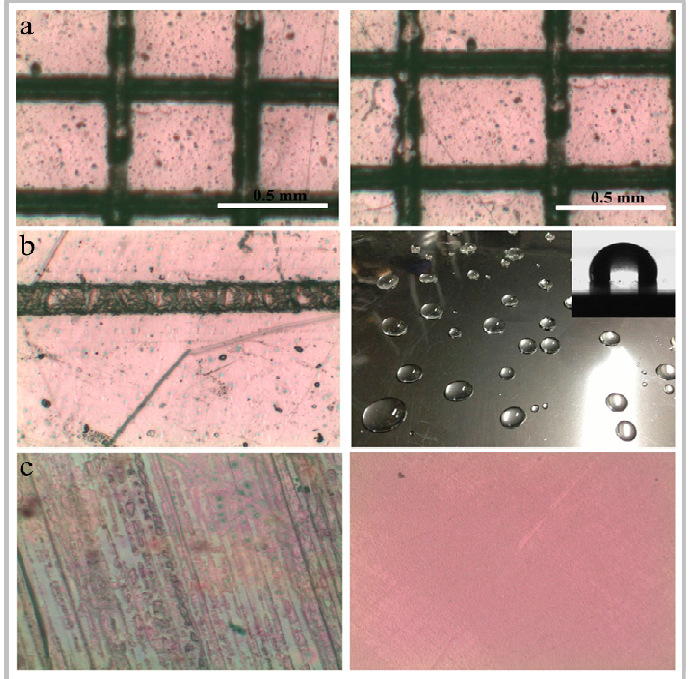
Figure 6. Scratch-resistant coating properties of the coated polyethylene terephthalate (PET) film. ( a ) Optical pictures of the coated films after cut-cross tape test (the left side shows a magnification of 1 time, and the right side shows a magnification of 10 times). ( b ) The left side shows the sample under the load of 1000 g left for the pencil scratch marks over 9 hours, and the water droplets on the coated PET film are shown in the right image. ( c ) Optical images of naked PET film. The PET film after coating is observed on the left and the right shows the coated PET film after wear test [149]. Copyright 2015, Polym. Int